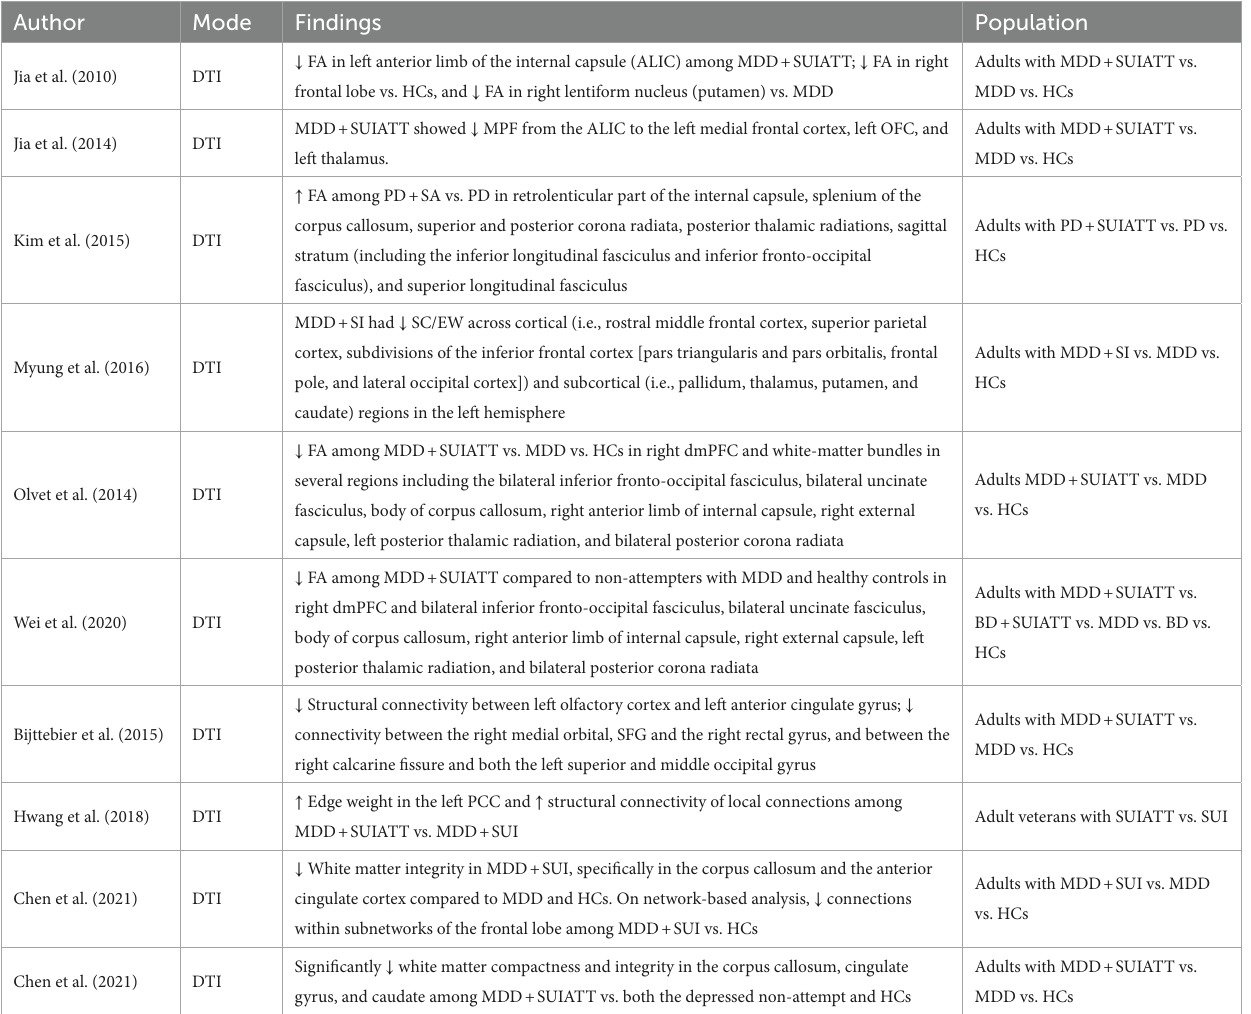
TABLE 4 Diffusion tensor imaging (DTI)